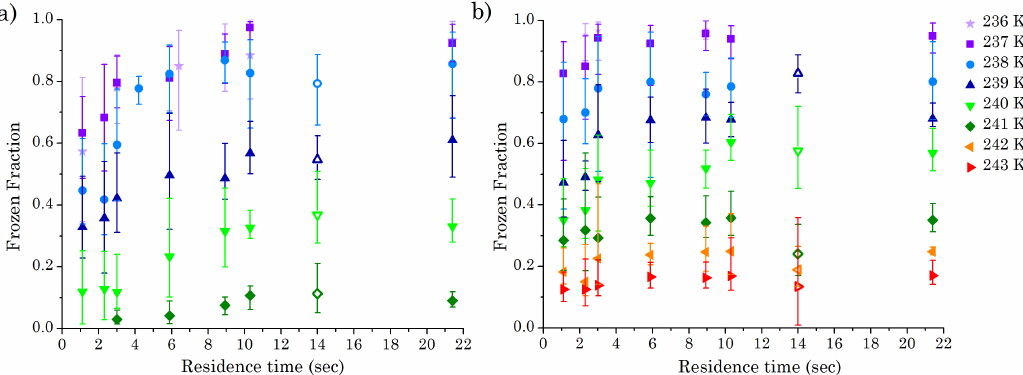
Fig. 5. Time dependent frozen fraction in the immersion mode for temperatures between 236K and 243K. Each point represents an average of 3 to 7 measurements. a) shows the results for size selected 400nm kaolinite particles and b) 800nm kaolinite particles. For comparison, results reported in L¨u¨ond et al. (2010) are shown as open symbols. Error bars represent the uncertainty in the frozen fraction due to the classification of particles as ice crystals or droplets (see Sect. 2.4 for